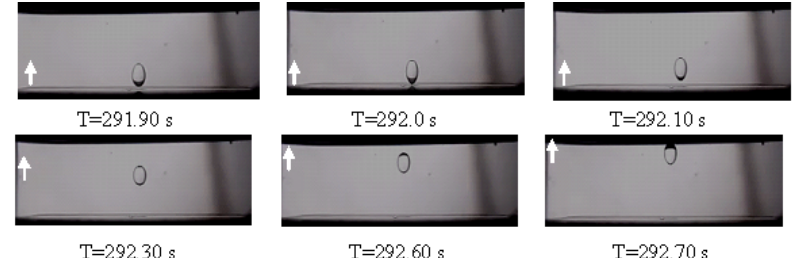
Figure 6. Rhythmic motion for drop resulted by coalescence at Ca E = 0 . 205. Fig. 6. Rhythmic motion for drop resulted by coalescence at Ca